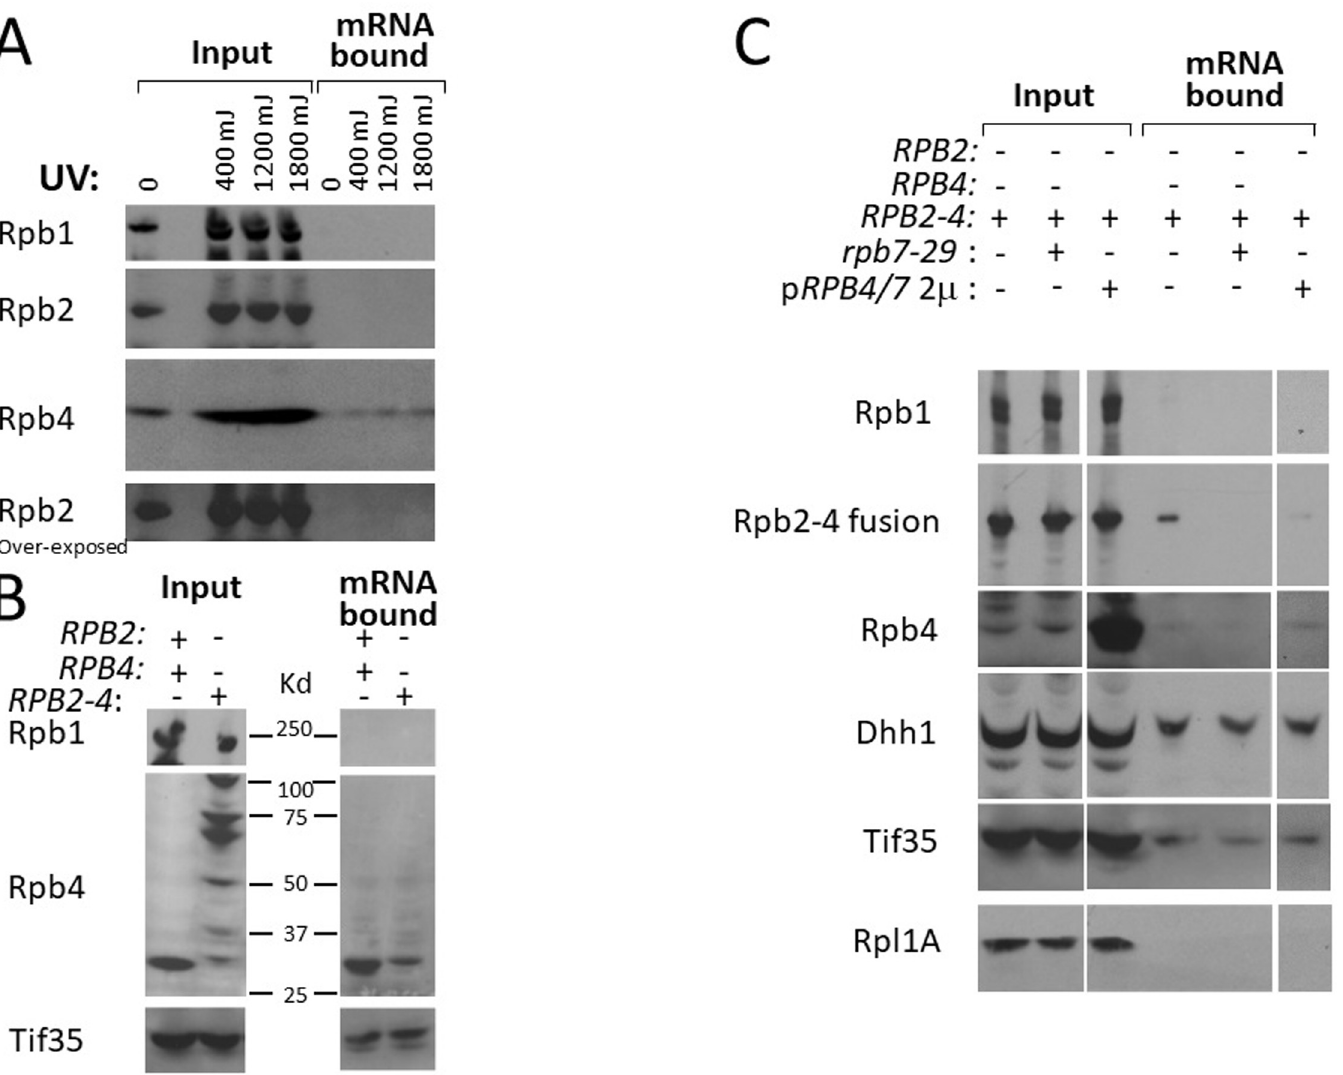
Fig 5. Endogenous Rpb4, Rpb2-Rpb4 fusion protein and the fusion-derived Rpb4 bind poly(A)+ RNAs. (A) Rpb4, but not Rpb2, binds poly(A)+ RNA. Live WT cells were irradiated with increasing doses of UV radiation, as indicated. RNPs were extracted from equal amount of cells and the poly(A)+ RNA was purified [27]. Proteins, which were captured by equal amount of mRNA (see Materials and methods), were analyzed by Western blotting. The membrane was cut at ~ 100 Kd into two pieces; the high MW portion was reacted with anti-Rpb2, whereas the low MW portion reacted with anti-Rpb4 antibodies. The high MW portion was then reacted with anti-Rpb1 Abs (anti-CTD). A 5-fold overexposure of the Rpb2 signal is shown in the lower panel. (B) Rpb4 derived from cleavage of the Rpb2-Rpb4 fusion protein binds poly(A) + RNA. WT and RPB2 - RPB4 cells were irradiated with 1200 mJ of UV. Poly(A)+ RNA was purified under denaturing conditions and RNA-associated proteins were analyzed as in (A). The membrane was cut as in A and reacted with the either anti-Rpb1 or anti-Rpb4 Abs. The membrane piece with the low MW proteins was later reacted with anti-Tif35 Abs. Tif35 is an eIF3 component and is shown as a loading control. (C) The Rpb2-Rpb4 fusion protein binds poly(A)+ RNAs in an Rpb4/ 7-dependent manner. The RPB2 - RPB4 strain was transformed with a high-copy plasmid encoding an Rpb7 mutant defective in Rpb4-binding (Rpb7-29) or a high-copy plasmid carrying both RPB 4 and RPB7 ORFs including their respective 5’ and 3’ non-coding regions (p RPB4/7 ). Poly(A)+ RNA was purified and RNA-associated proteins were analyzed as in